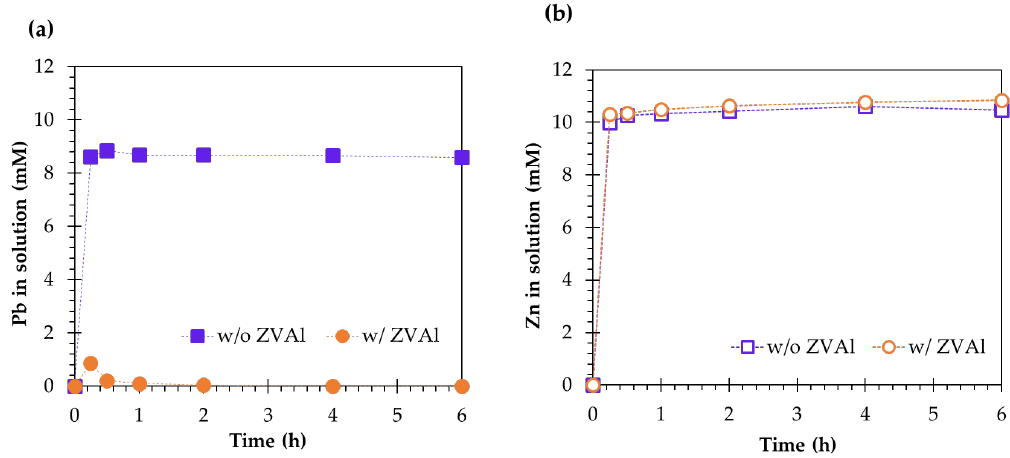
Figure 4. Concentration of ( a ) Pb and ( b ) Zn dissolved in the leaching solution as a function of time when zinc plant leach residues (ZPLRs) were leached without and with zero-valent aluminum (ZVAl). The concentration of dissolved Pb when ZVAl was added was 10-fold lower than when only ZPLRs were leached in the same solution. The dissolved concentration of Pb decreased further with increasing the treatment time and reached below 0.048 mM (i.e., 0.1 mg/L) with ZVAl after 4 h. The dramatically lower dissolved concentration of Pb after 15 min and its continued decrease to below 0.1 mg/L with ZVAl could be attributed to its sequestration from the solution via cementation. In other words, an additional chemical reaction—cementation described by the overall reaction (Equation (7)) which is the sum of two half-reactions (i.e., Equations (5) and (6))—occurred concurrently with dissolution reactions, as previously described.